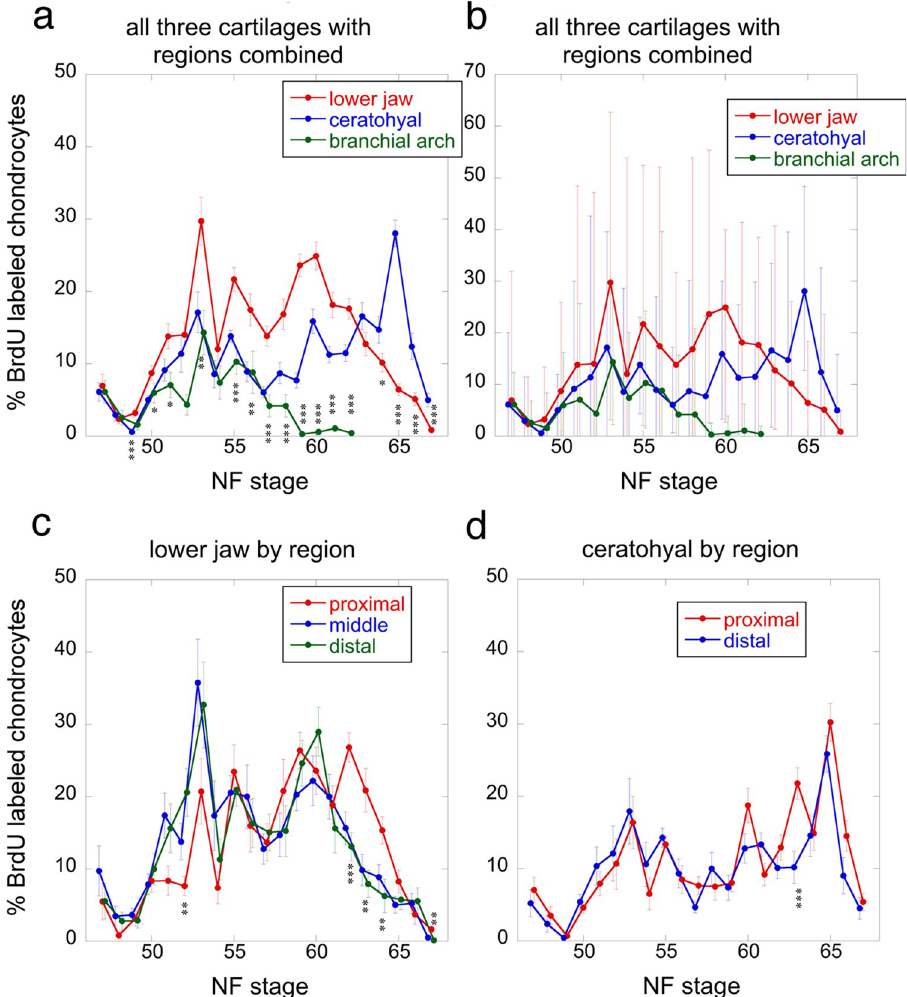
Fig 5. Percentages of BrdU-labeled chondrocytes for lower jaw, ceratohyal and branchial arch cartilages from NF 47 to 67. Each stage was scored from 5–9 specimens using 10 X photos of 10 μ m-thick sections through central portions of left and right regions at the approximate locations of the boxes in Fig 1 NF 56 and 62, total number of specimens is 155; error bars show standard errors in a and c-d, and minimum and maximum values in b; asterisks indicate a significant difference among cartilages for a stage in a and among regions within a cartilage in c and d; one asterisk means p < 0.05, two means p < 0.01, and three means p < 0.001 using ANOVA in R. 59, the start of metamorphosis. At this point, ceratobranchial measurements were discontin- ued due to the onset of cartilage resorption and ceratohyal chondrocytes start to decrease rap- idly, reaching 15 μ m by the end of metamorphosis, NF 66. The lower jaw shows significant differences among regions at almost all stages in both 5 and 10 μ m sections (Fig 7B and 7D). The ceratohyal shows significant differences among regions at a few larval stages and most metamorphic stages (Fig 7C). Proximal and distal regions have the lowest and highest values respectively at almost all stages for the lower jaw, and from NF 61 onwards for the ceratohyal. The cell size trajectories for lower jaws sectioned at 5 and 10 μ m have generally similar shapes, magnitudes of values, and relationships among regions, though the regions differ less when sectioned at 5 μ m (Fig 7B and 7D).